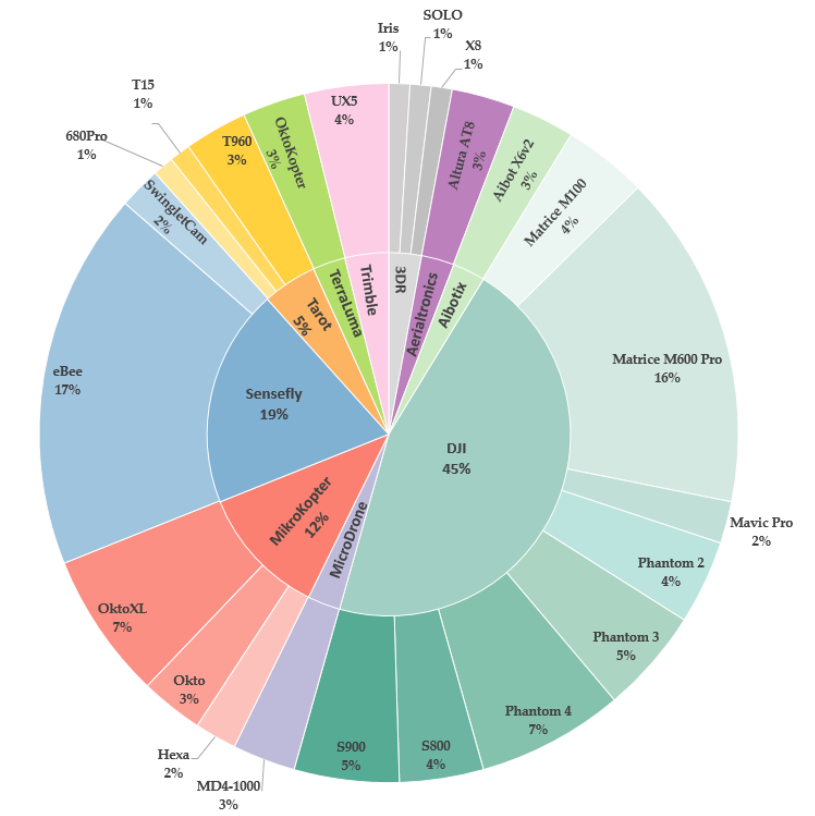
Figure 11. Preferred brands of UAV platforms used in the surveyed studies with percentages and values for each brand.